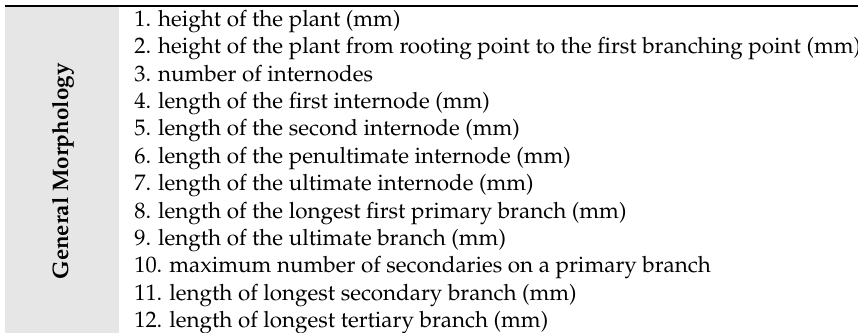
Table 2. Characters measured for the morphometric analyses. The characters labelled with an asterisk are qualitative, the other ones are